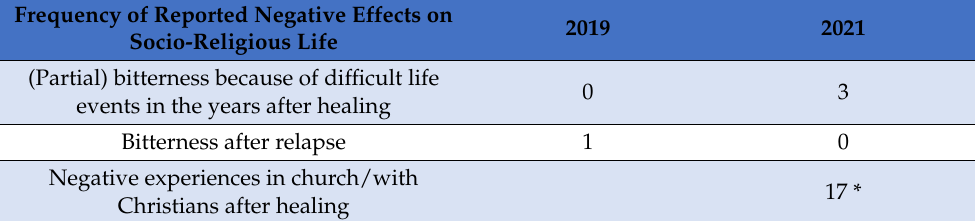
Table 16. negative effects mentioned on socio-religious